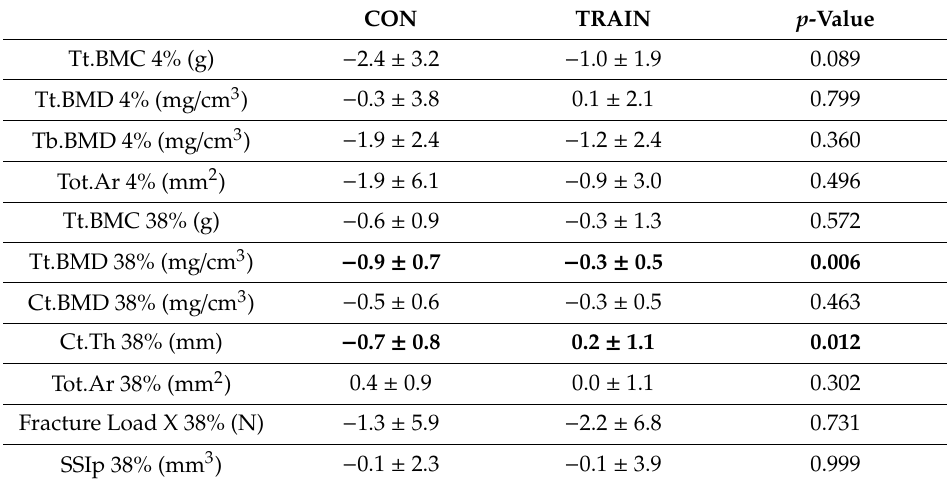
Table3. Di ff erencesinpercentagesofchangeofbone-relatedvariablesbetweenCONandTRAINgroups.